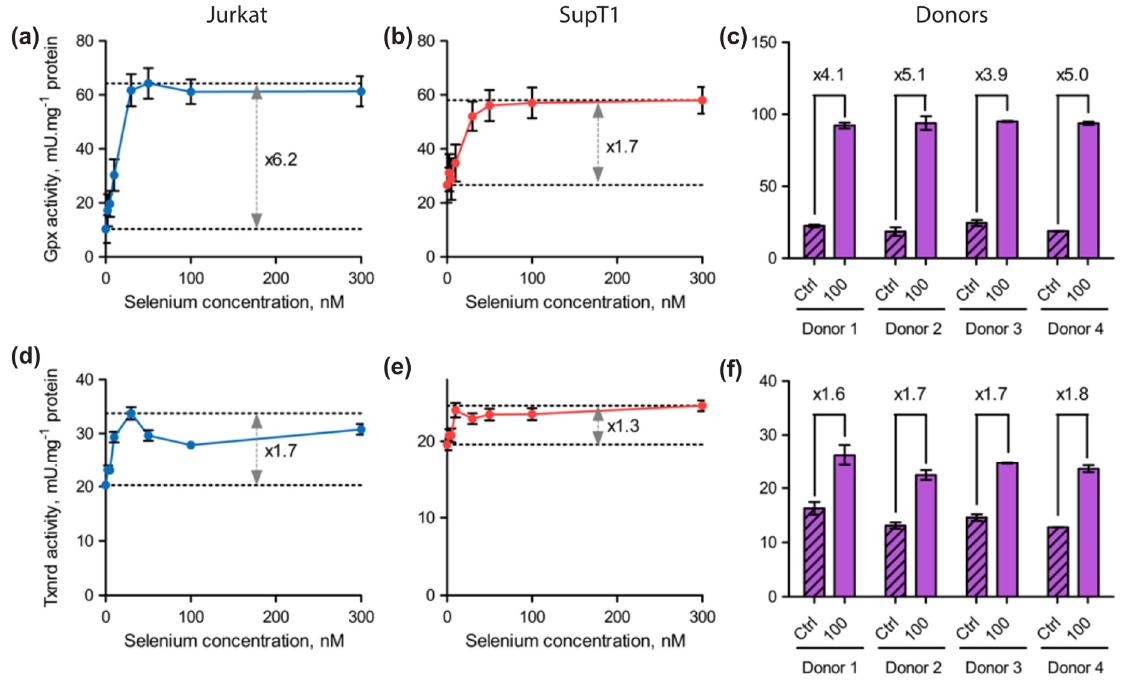
Figure 6. Evaluation of GPX ( a – c ) and TXNRD ( d – f ) enzymatic activities in protein extracts from various T cell types (Jurkat, SupT1 and the four donors) cultured with different concentrations of supplemented selenium. The GPX activities were represented for Jurkat ( a ) ( n = 1), SupT1 ( b ) ( n = 1) and the four donors ( c ) ( n = 2) for the different growth conditions. The TXNRD activities were represented for Jurkat ( d ) ( n = 1), SupT1 ( e ) ( n = 1) and the four donors ( f ) ( n = 2) for the different growth conditions. The experiments were done in technical triplicates. The differences between the lowest and highest values were indicated by an arrow or a bar (± standard deviation), with the corresponding fold-change factor beside or above.